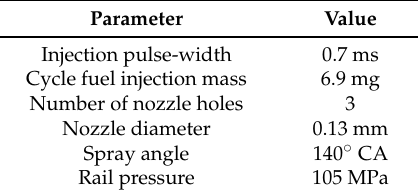
Table 4. Injection parameters.